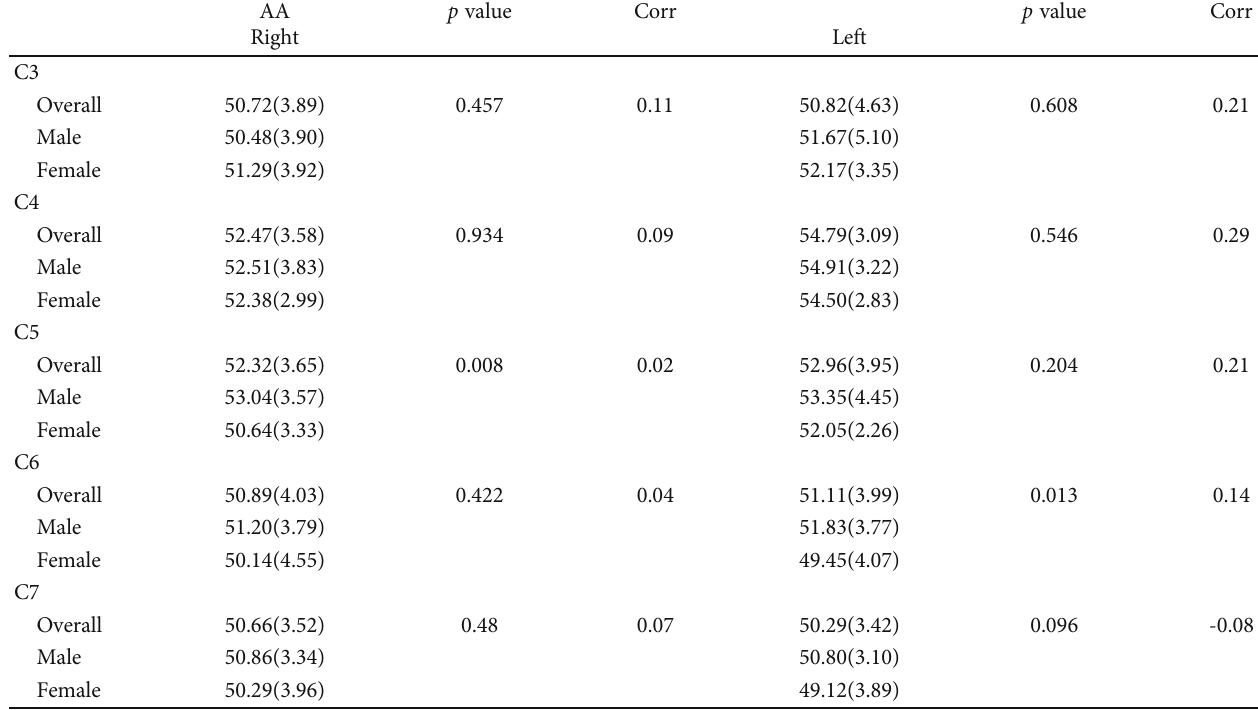
Table 3: Axial cervical pedicle angles of 70